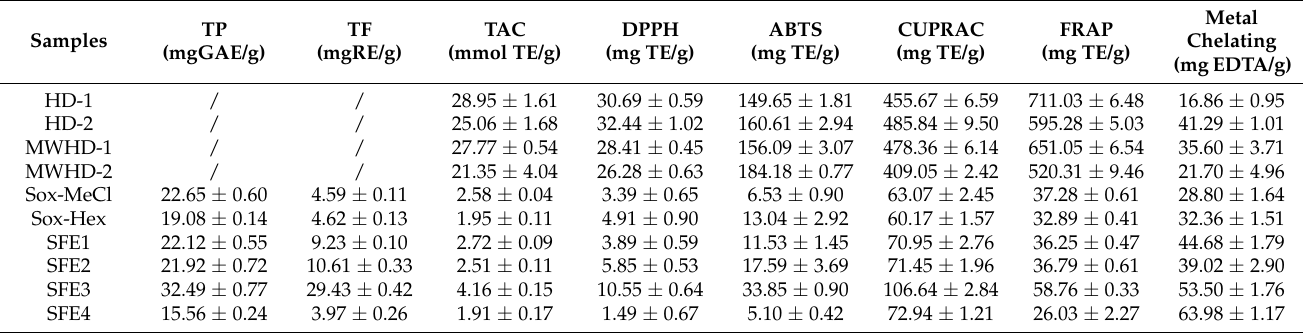
Table 1. Polyphenols content and antioxidant activity of chamomile essential oils, Soxhlet, and supercritical CO 2